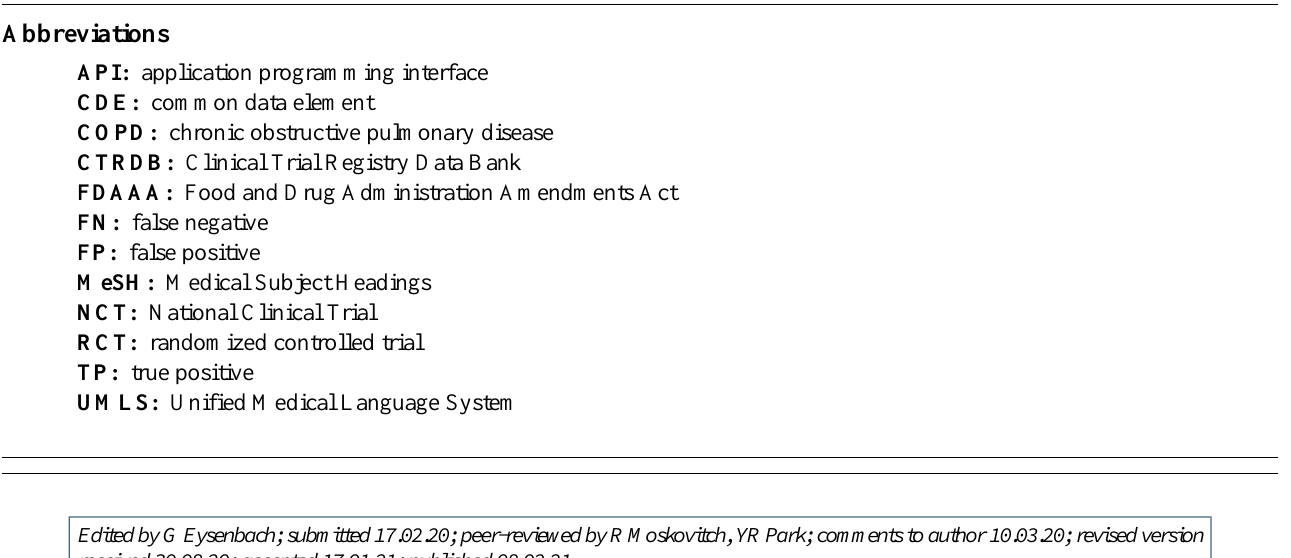
Algorithm Development and Validation